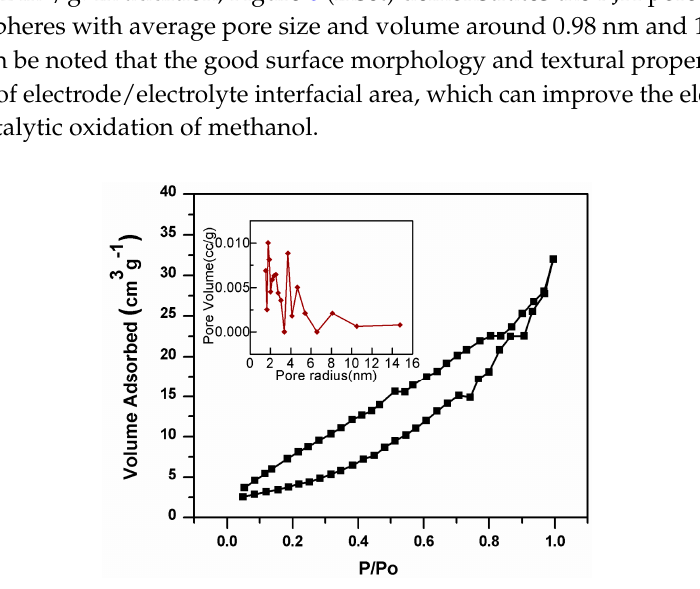
Figure 6. N 2 adsorption-desorption isotherms of Co 3 (PO 4 ) 2 nanospheres. The inset of Figure 6 shows the pore size